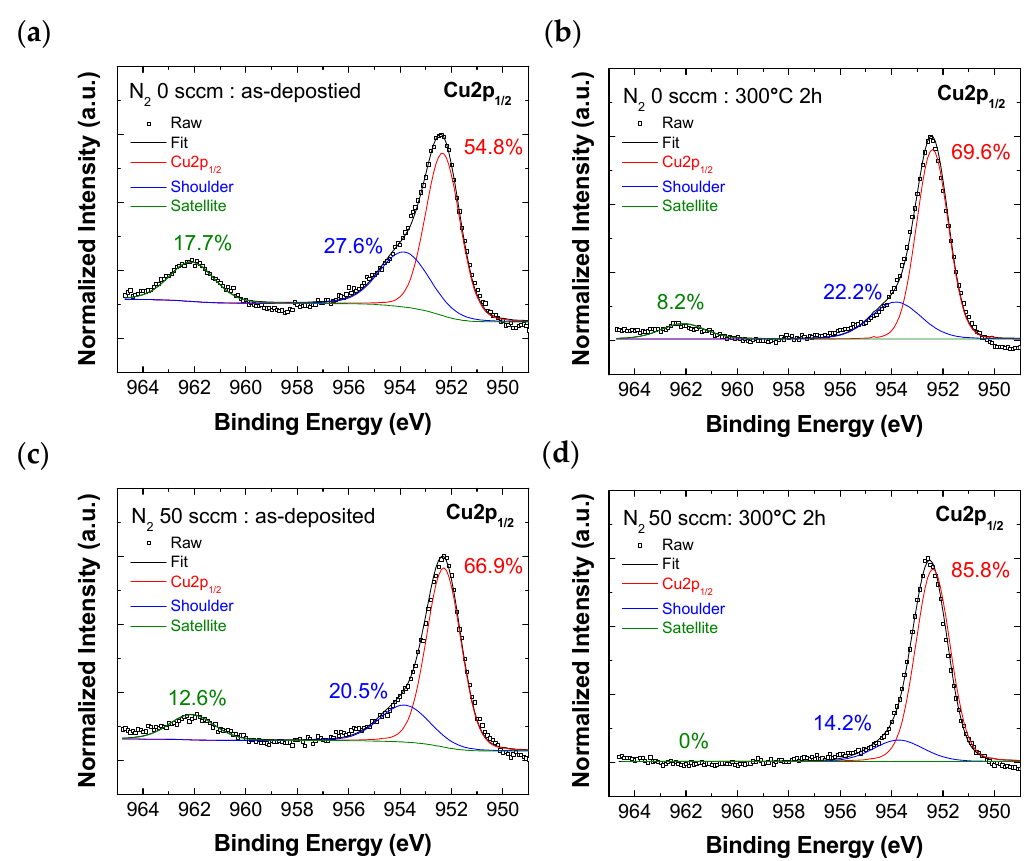
Figure 4. X-ray photoelectron spectroscopy (XPS) Cu 2p 1/2 peaks of ( a ) as-deposited Cu x O, ( b ) annealed Cu x O, ( c ) as-deposited CuON, and ( d ) annealed CuON. The relative atomic compositions of Cu x O and CuON films are indicated in Table 1. Only the annealed CuON film exhibits a Cu:O composion ratio of 2:1, while the other samples exhibit Cu:O ratios near 1:1. In accordance with the XRD results, it may be concluded that the incorporated nitrogen promotes the transition from CuO to Cu 2 O after thermal treatment. Table 1. The atomic compositions of Cu x O and CuON films obtained by XPS analysis. Experimental